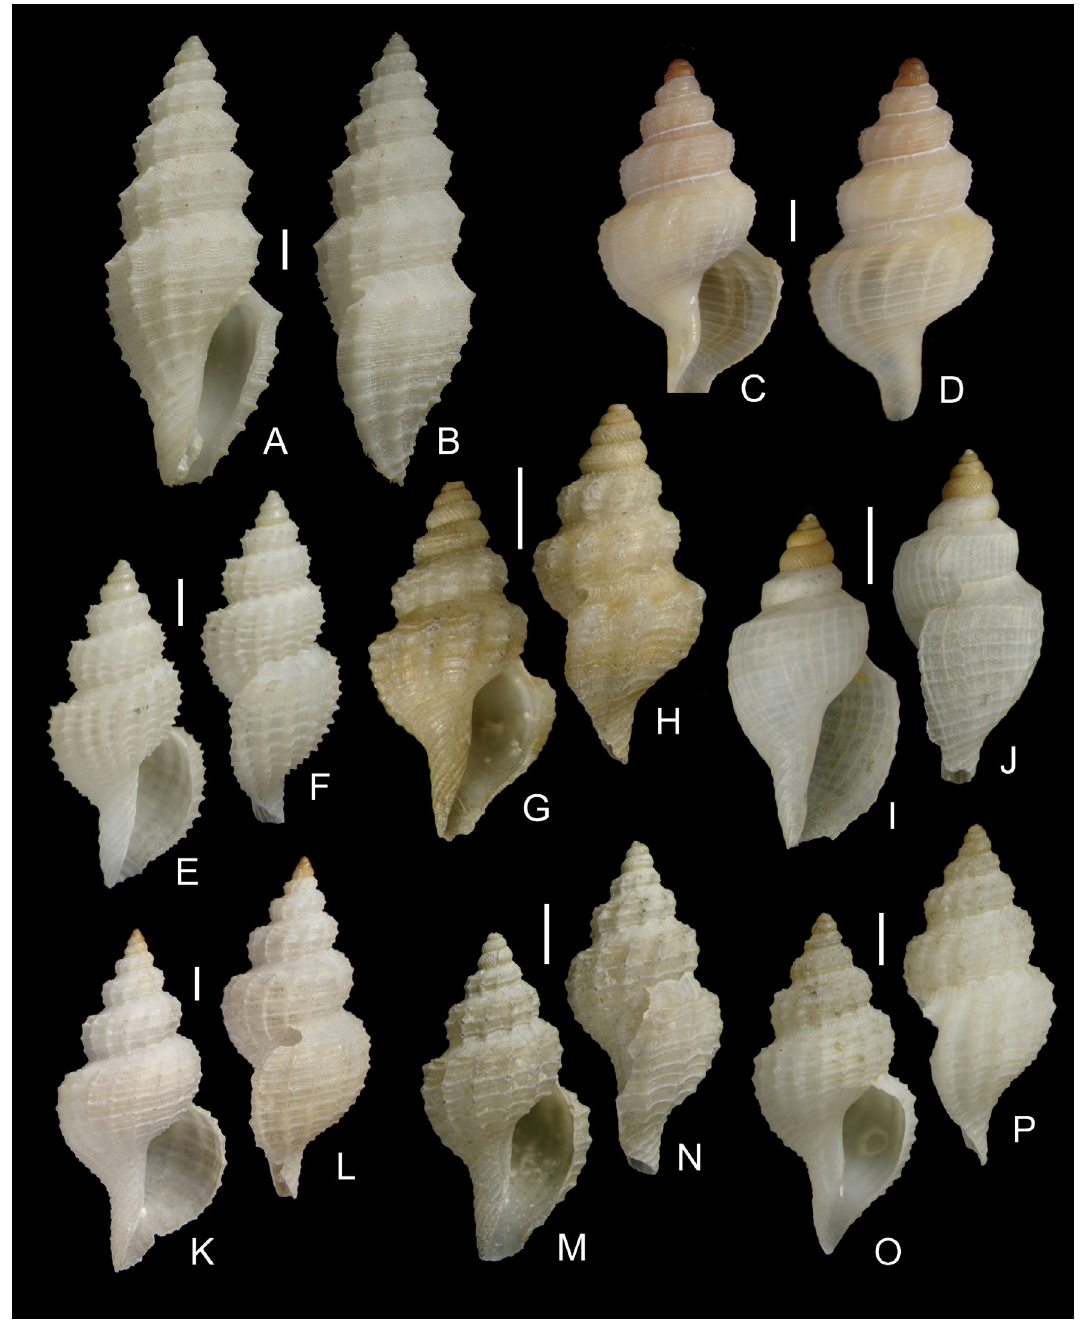
Fig. 27. Conoidea 2 (Mangeliidae, Raphitomidae). A–B . Kurtziella serga (Dall, 1881), SEAMOUNT